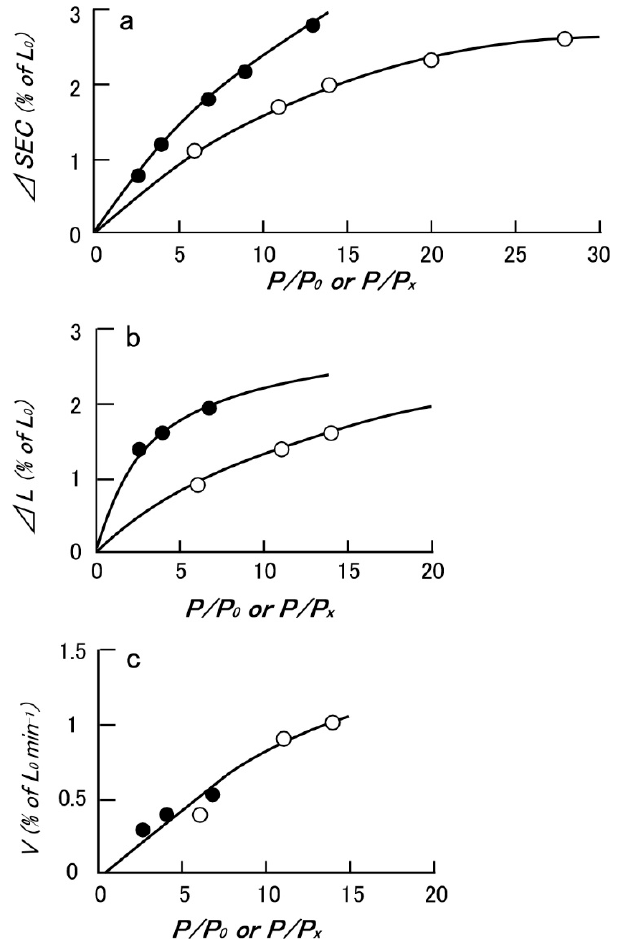
Figure 4. Typical example showing the effect of isotonic load (P/Po or P/P X ) on the extension of SEC ( Δ SEC) ( a ), the distance of early isotonic lengthening ( Δ L) ( b ), and the velocity of late isotonic lengthening ( c ). Filled and open circle data points were obtained from the ABRM generating active tension (Po), and maintaining catch tension (P X ), respectively. (Mukou et al. [21]).